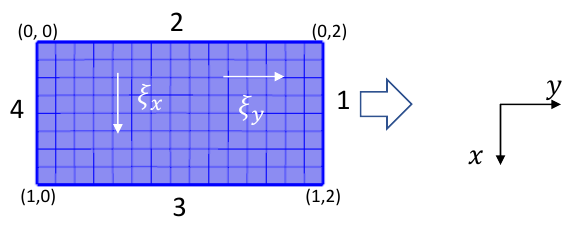
Figure 4. Finite Element Model used in the present study. The numbers 1 – 4 placed near the sides of rectangle denote boundary 1 – boundary